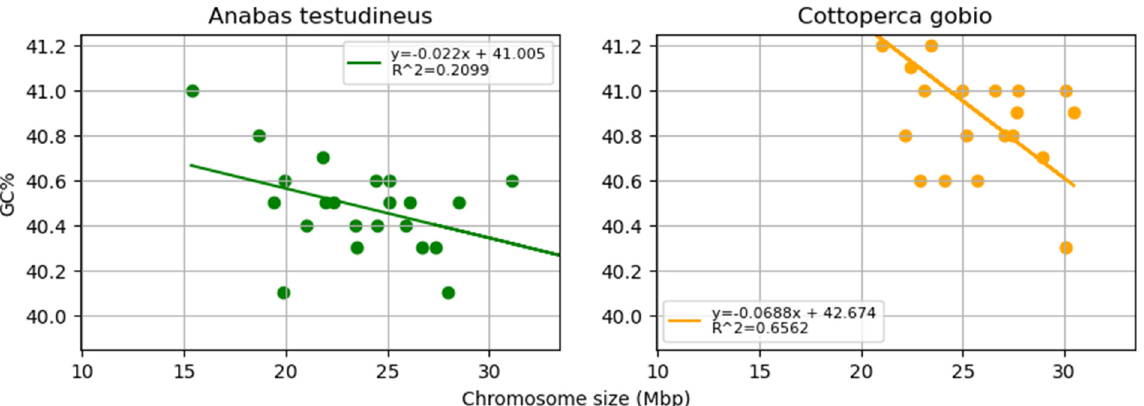
Figure 1. Relationships between the GC% and corresponding chromosome size in Anabas testudineus ( left ) and Cottoperca gobio ( right ) on equidistant axes. Table 1. Summary of the species studied and their genome assemblies.